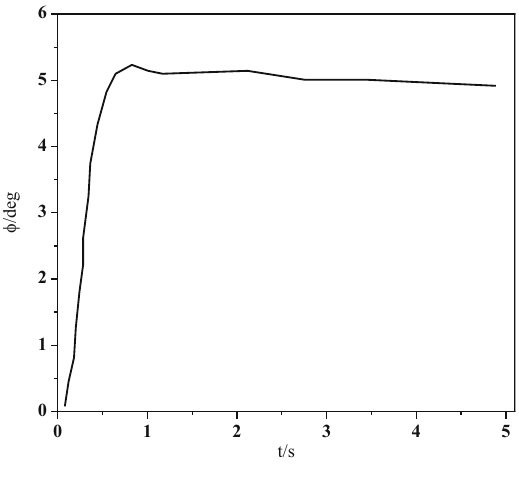
Figure 9: Rolling control